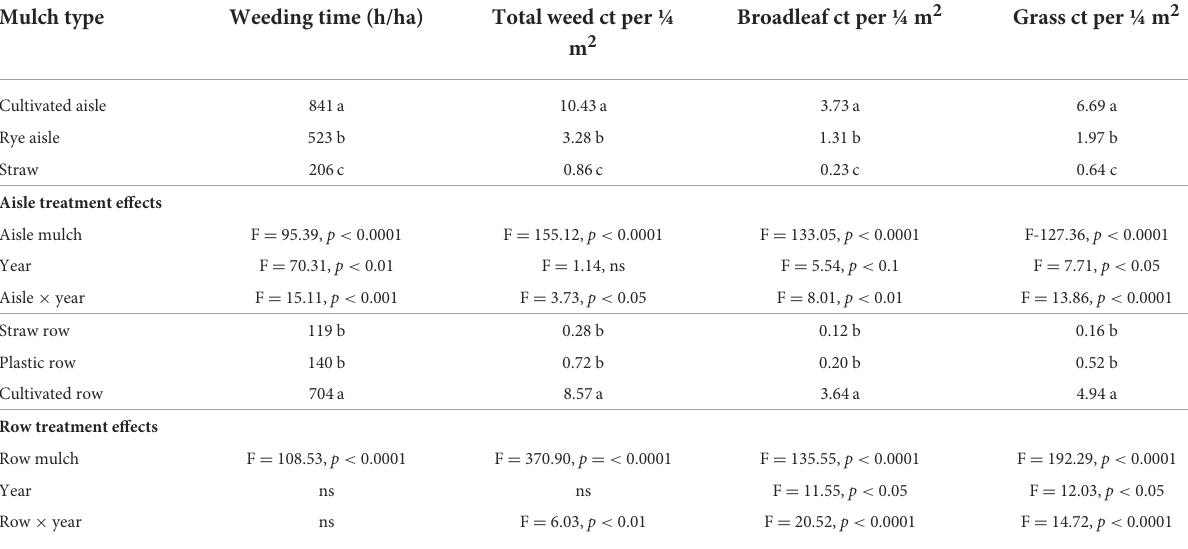
TABLE 5 Weed counts and management time in 2018 and 2019 relative to row and aisle mulch